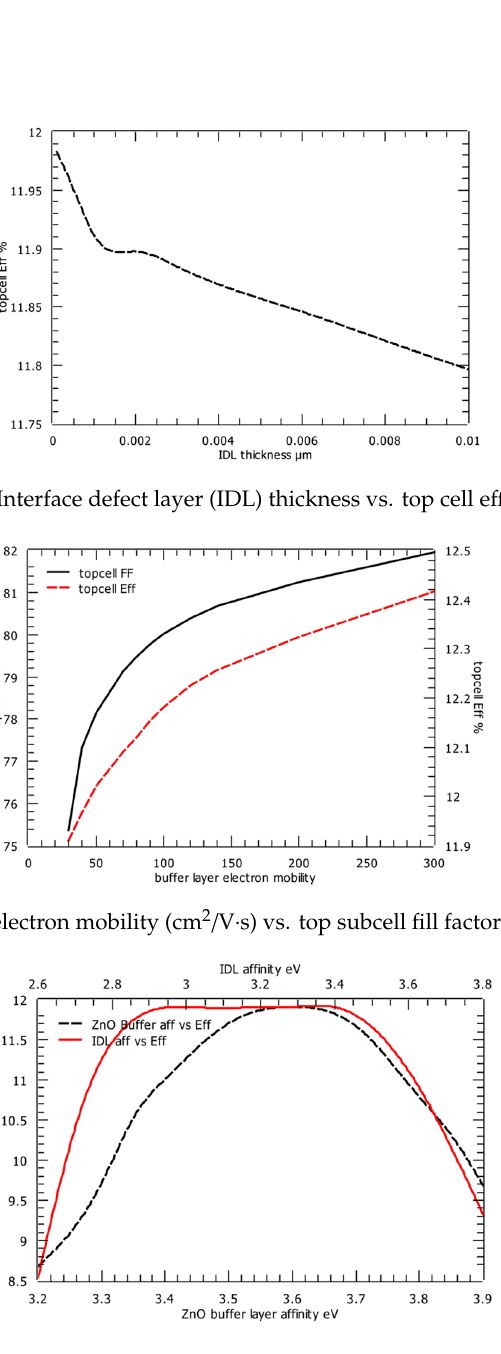
Figure 5. Bu ff er and IDL a ffi nity vs. subcell e ffi Figure 5. Buffer and IDL affinity vs. subcell efficiency. Figure 5. Buffer and IDL affinity vs. subcell efficiency. Figure 5. Buffer and IDL affinity vs. subcell efficiency.